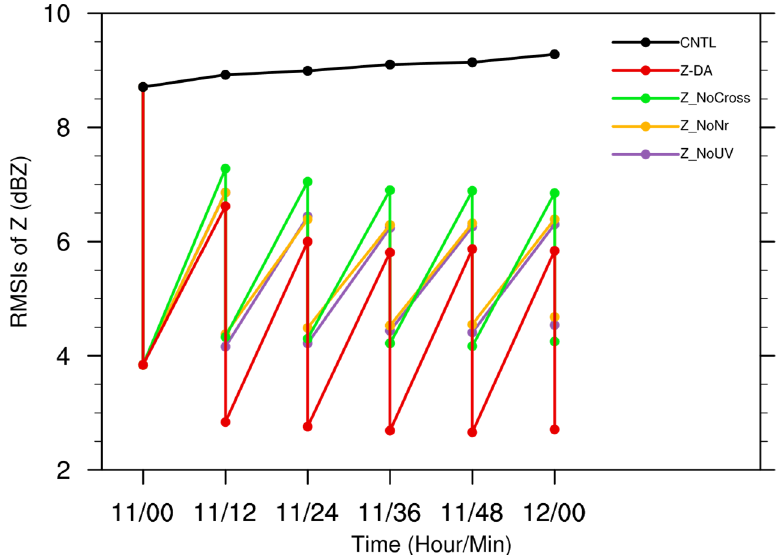
Figure 7. RMSIs of simulated reflectivity in experiments Z-DA (red line), Z_NoUV (purple line), Z_NoNr (orange line), and Z_NoCross (green line). The RMSI for experiment CNTL is shown in black line as a reference.